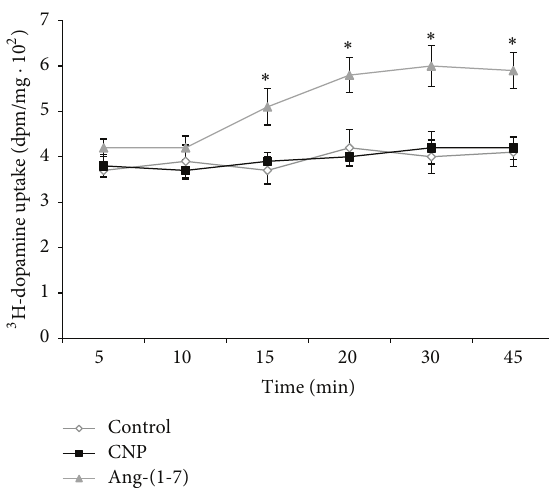
Figure 2: Effects of 100 nM CNP and 100nM Ang-(1-7) on the time-course curve of 3 H-dopamine uptake in isolated renal cortex samples, between 5 and 45 min. 3 H-dopamine uptake is expressed as dpm/mg ± SEM. ∗ 𝑝 < 0.01 compared with control. Number of samples: 8–10.